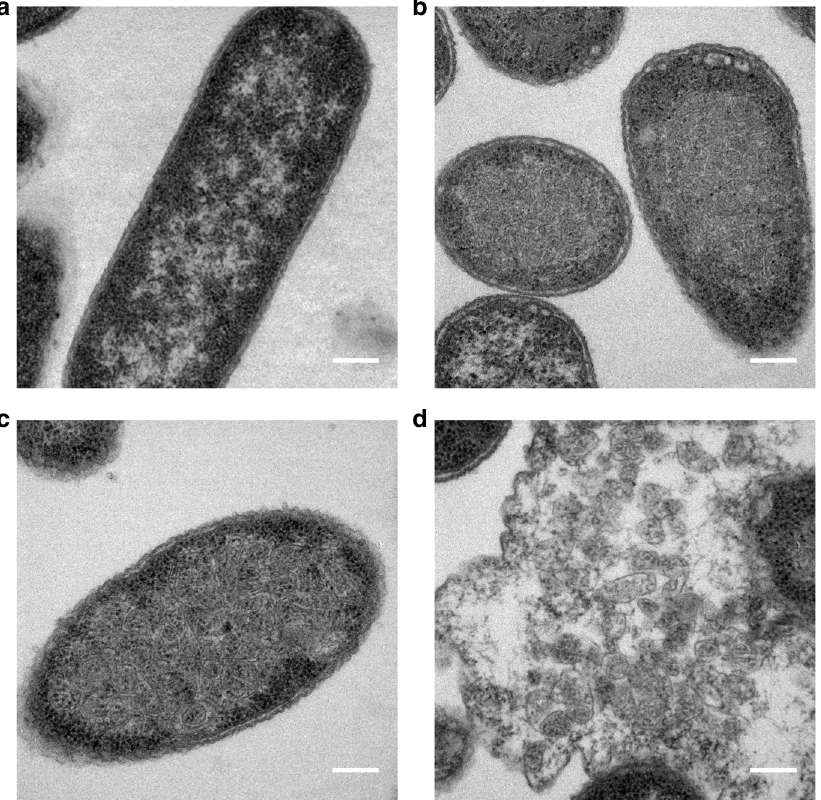
Fig. 2 Minimal requirements for BMC shell formation. TEM analyses of resin embedded, thin sectioned, E. coli BL21 * (DE3) cells ( a ) control strain transformed with empty vector ( b ) producing the shell proteins PduA, B, B ′ , J, K, N and U (PduA-U) ( c , d ) producing the shell proteins PduB, B ′ , J, K, N and U (PduB-U). c In vivo, and d from lysed cells. Scale bars show 0.2 µ